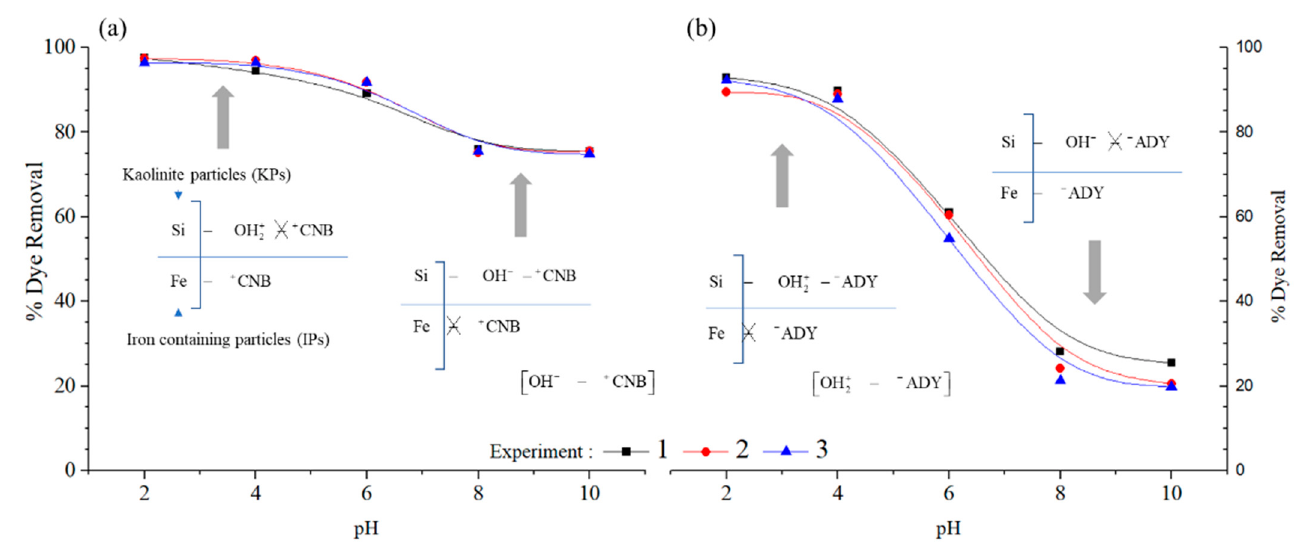
Figure 4. ( a ) Effect of pH on Basic Navy Blue 2RN (CNB) removal. ( b ) Effect of pH on Drimaren Yellow Cl-2R (ADY) removal. Adsorbate concentration 50 mg/g. Adsorbent dose 0.5 g/50 mL.